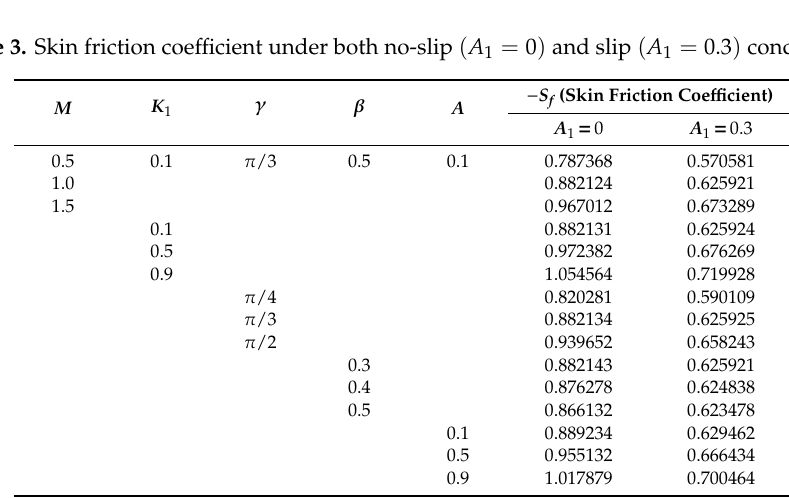
Figure 10. Temperature profiles owing to varying values of ε .